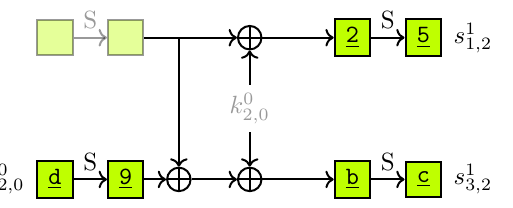
Figure 5: An illustration of a higher-order linear constraint for SKINNY-64-128 . k n represents the ( r, c ) key cell at round n .